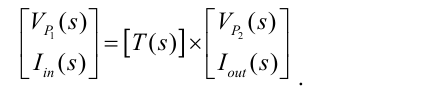
Figure 2: ICs based circuit under study.